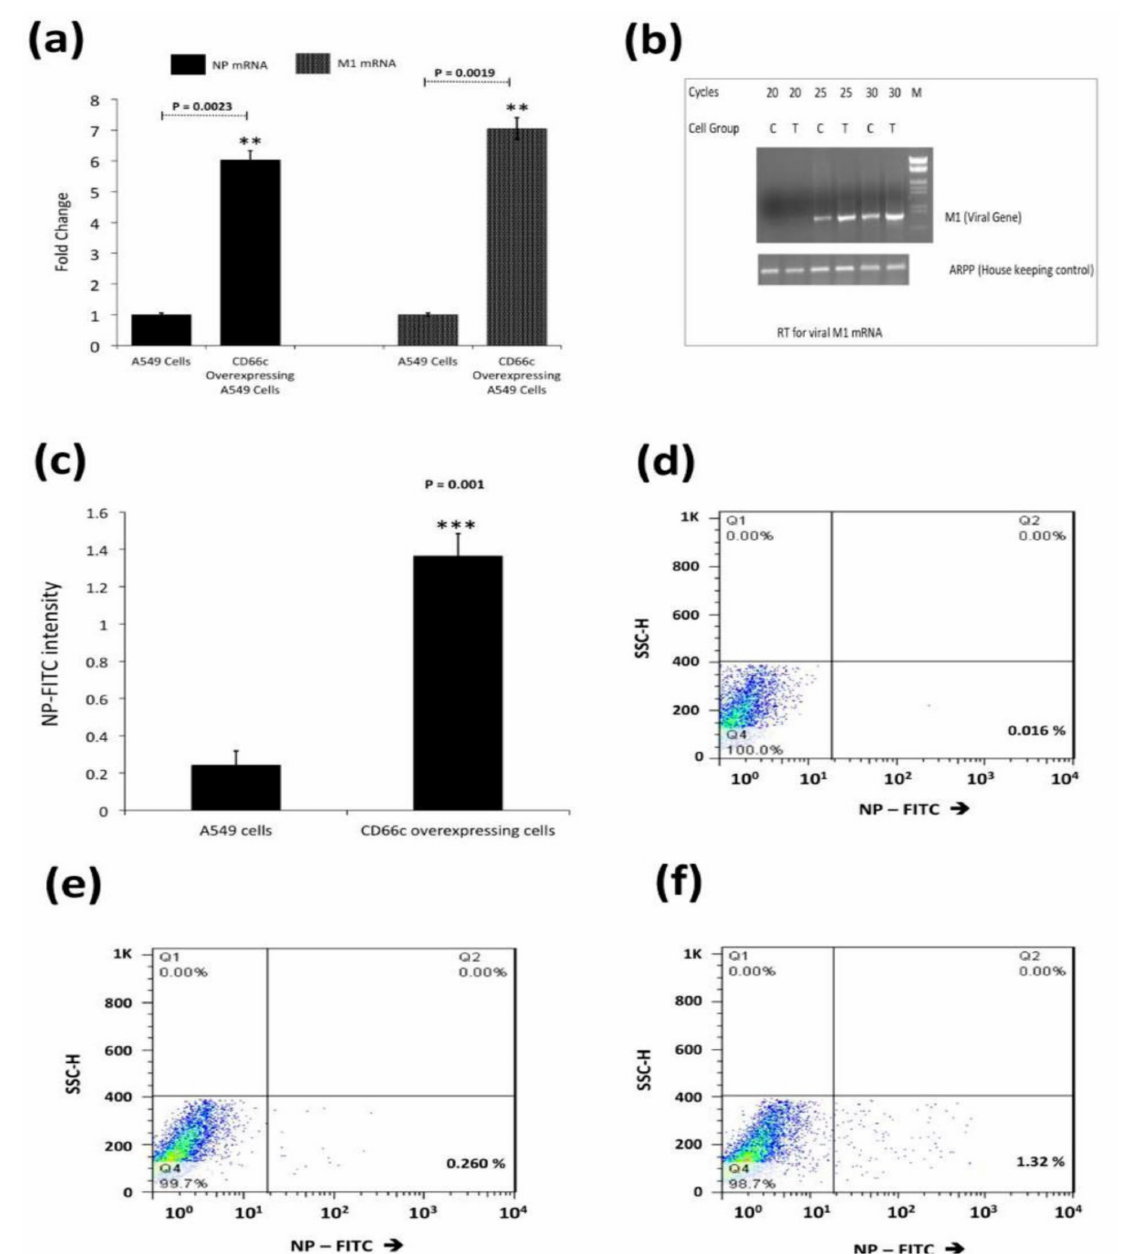
Figure 2. ( a ): Real time quantification of NP and M1 mRNA in viral infected A549 cells 8 h post infection (8 h.p.i) infected cells. Figure shows higher mRNA levels of NP (left two bars) and M1 (right two bars) in cells overexpressing CD66c. Each bar represents mean of five independent experimental readings. ( b ): Semi quantification of viral M1 by RT-PCR. For the above-mentioned reaction condition (8 h.p.i, and 1) viral M1 mRNA was also measured semi-quantitatively. Before each lane A549 control cells is denoted as ‘’C”, or A549 cells having overexpressed CD66c with “T”. Cycles are the number of PCR cycles. ( c ): Flow cytometric analysis for virus load in A549 infected cell: The bar diagram shows rise in viral NP in CD66c overexpressing A549 cells (right) than that in A549 cells (left). Each bar represents mean values of at least three independent experiments ± SD. Statistical significance was assessed by student’s t -test, (**) for p ≤ 0.01 and (***) for p ≤ 0.001. ( d ): Representative FACS snapshot of unstained A549 cells showing no signal corresponding to NP-FITC in lower-right quadrant; cells with some signal in ( e ); cells overexpressing CD66c with increased NP-FITC signal in lower-right quadrant ( f